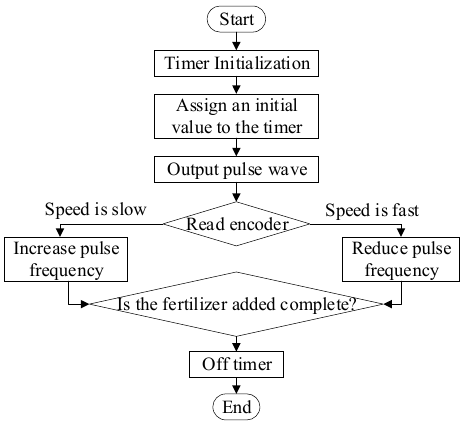
Figure 2. Stepping motor drive control process flowchart.